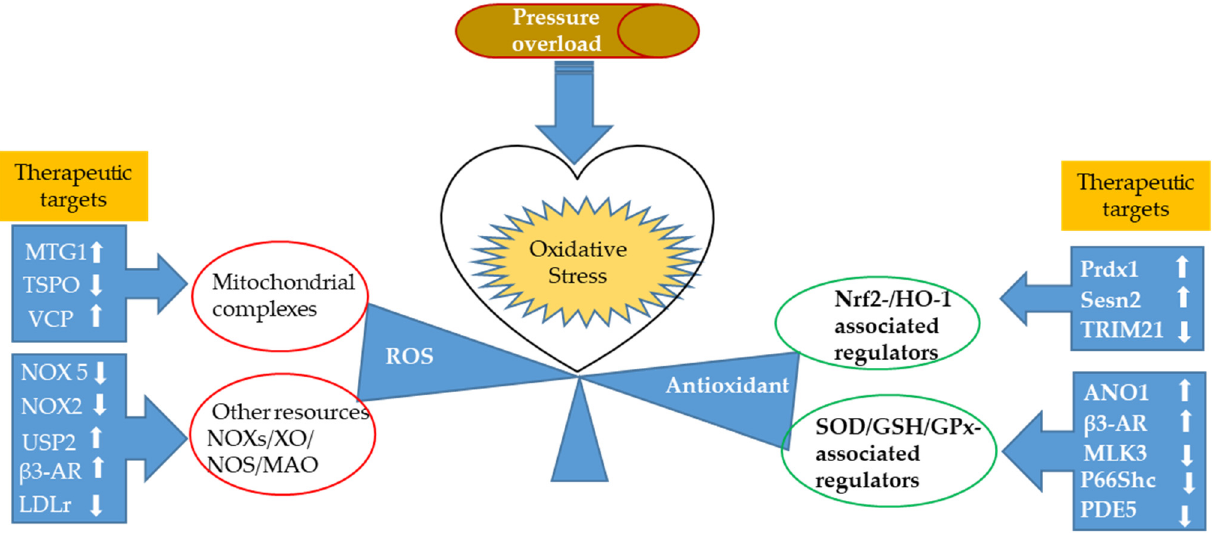
Figure 1. The updated potential therapeutic targets involved in attenuating cardiac oxidative stress resulted from pressure overload. There have been newly identified diverse therapeutic targets that regulate cardiac oxidative stress induced by pressure overload in animal models. Cardiac-specific overexpression of mitochondrial GTPases 1 (MTG1), valosin-containing protein (VCP), and conditional knockout of mitochondrial 18 kDa translocator protein (TSPO) could preserve cardiac mitochondrial quality and integrity, reduce ROS production, and attenuate myocardial injury under pressure overload. Genetic deletion of NADPH oxidase 5 (Nox5), NADPH oxidase 2 (Nox2), and low-density lipoprotein receptor (LDLr) suppress Nox activity and subsequent Nox-dependent ROS production to protect pressure-overloaded hearts from oxidative injury. Stimulation of ubiquitin- specific protease 2 (USP2) and β 3-adrenergic receptor (AR) also exert substantial Nox inhibition to counteract cardiac oxidative stress. From the perspective of enhancing antioxidative defense, overexpression of peroxiredoxin-1 (Prdx1), Sestrin2 (Sesn2), and genetic ablation of tripartite motif containing-21 (TRIM21) could upregulate nuclear factor erythroid-2 related factor 2/heme oxygenase- 1 (Nrf2/HO-1) pathway that subsequent active antioxidants defend against cardiac oxidative stress induced by pressure overload. Anoctamin-1 (ANO1) overexpression, deletion of mixed lineage kinase 3 (MLK3), and Src homology/collagen (Shc) adaptor protein (P66Shc) could upregulate major antioxidants in the heart, such as superoxide dismutase (SOD), glutathione (GSH), and glutathione peroxidase (GPx), to protect the stressed heart from oxidative